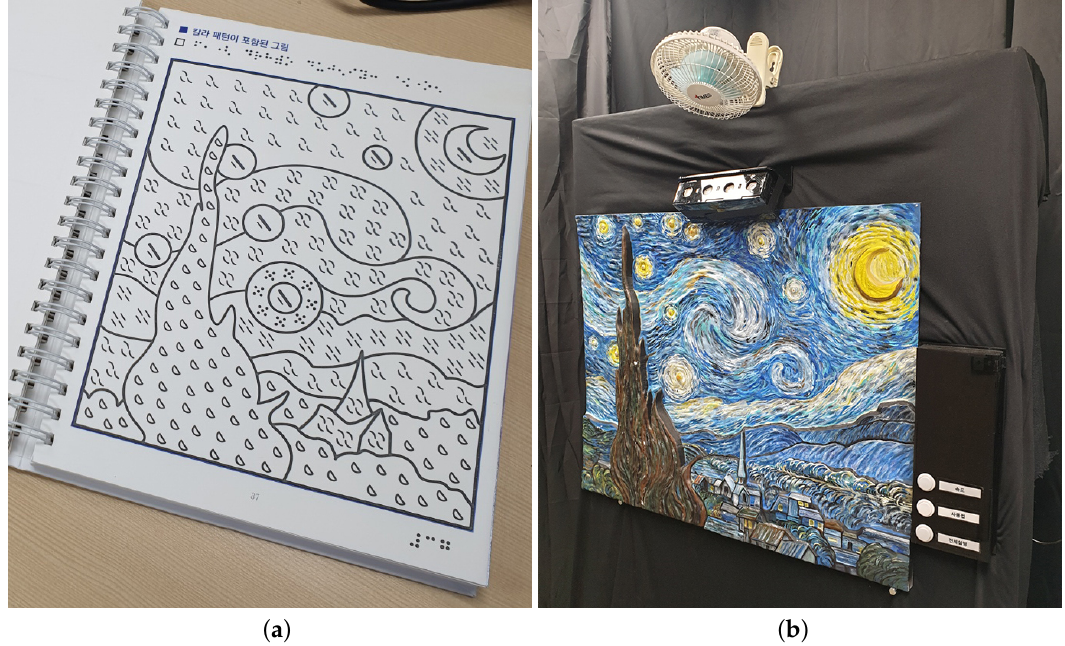
Figure 2. ( a ) Tactile graphic version of Van Gogh’s Starry Night featuring the tactile color patterns described in Reference [32] used during the evaluation. ( b ) Visual sensory substitution prototype that expresses color contents through sound and